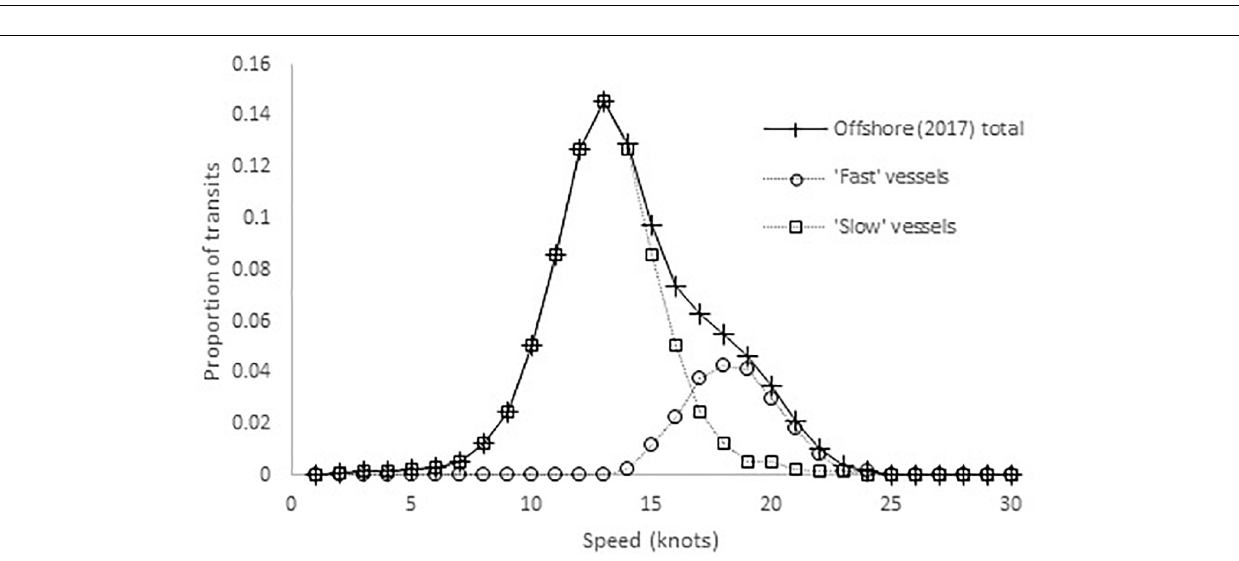
FIGURE 1 | Proportion of transits by speed for offshore traffic (crossing Indian Ocean south of Sri Lanka) and coastal traffic in the eastern Ionian, Mediterranean.